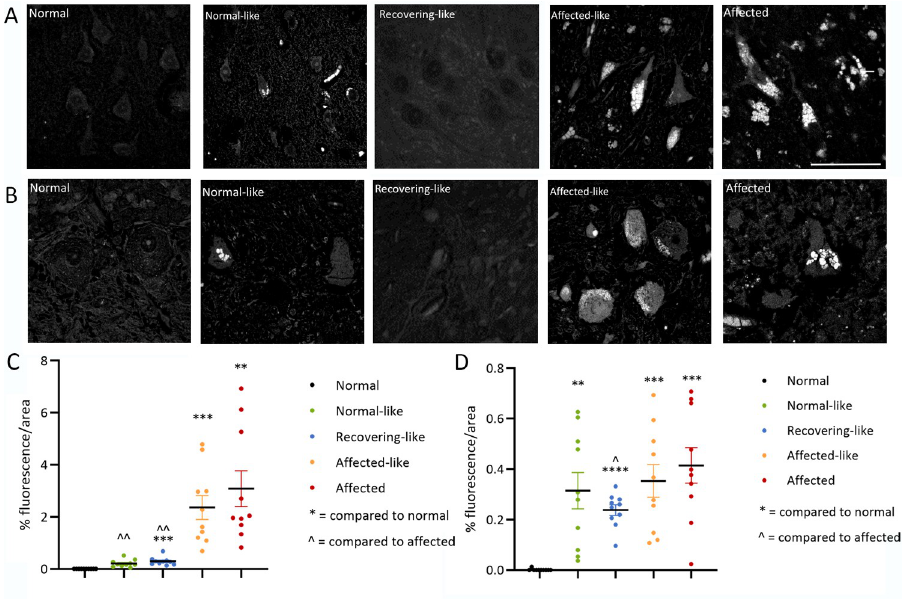
Fig 5. Fluorescent storage body accumulation in the cortex and cerebellum. Representative images and quantification of fluorescent storage body accumulation in the cortex ( A, C ) and cerebellum ( B, D ). Storage bodies accumulate throughout the cortex and cerebellum of affected controls and affected-like chimeras. In particular, pyramidal cells in the cortex and Purkinje cells in the cerebellum are densely packed with globular storage deposits. Conversely, storage bodies in the cells of the normal-like chimera, N1, are not tightly packed and many cells exhibit no storage at all, similar to normal controls in which storage bodies do not accumulate. No overt storage body deposits were observed in the remaining normal-like chimera, N2, and the recovering-like animals, R1, R2, R3 although quantitative analysis revealed more low-level background fluorescence in these animals than normal controls. Scale bar represents 50 μ m. �� and ˆˆ indicate P < 0.01, ��� indicates P < 0.001, ���� indicates P < 0.0001.